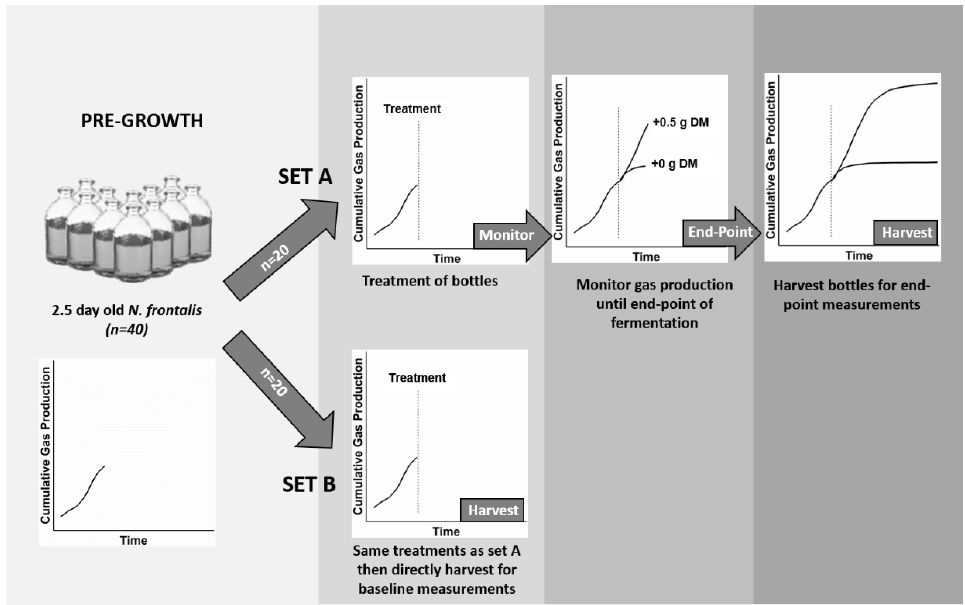
Figure 1. Schematic summary of the modified in vitro gas production technique. Neocallimastix frontalis cultures ( n = 40) were first pre-grown for 2.5 days on 0.25% ( w / v ) barley straw before being divided into two sets of bottles (A and B). Both sets ( n = 20) had the same five treatments ( n = 4): either + 0.5 g dry matter (DM) of one of four di ff erent test substrates or + 0.0 g of DM in the case of the control bottles. Set B bottles were harvested at zero time for baseline measurements. Set A bottles were used to monitor the fermentation kinetics before being harvested for end-point measurements. Each replicated set ( n = 4) of A bottles had a corresponding set ( n = 4) of replicated B bottles.